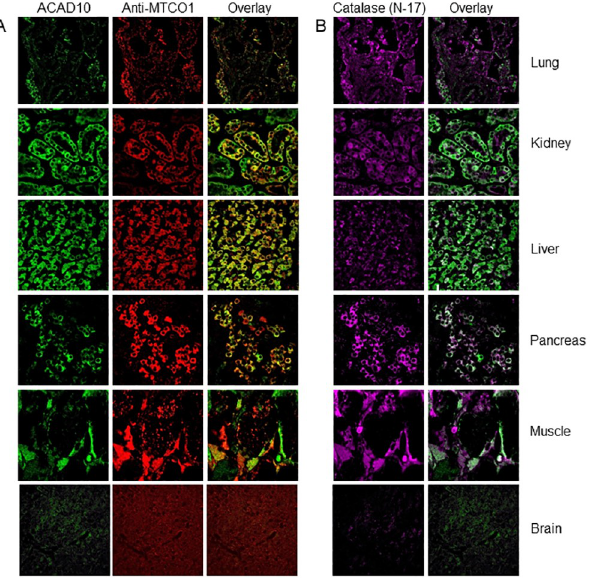
Table 1. Acylcarnitines in wild-type and Acad10 -deficient mouse brain and plasma.